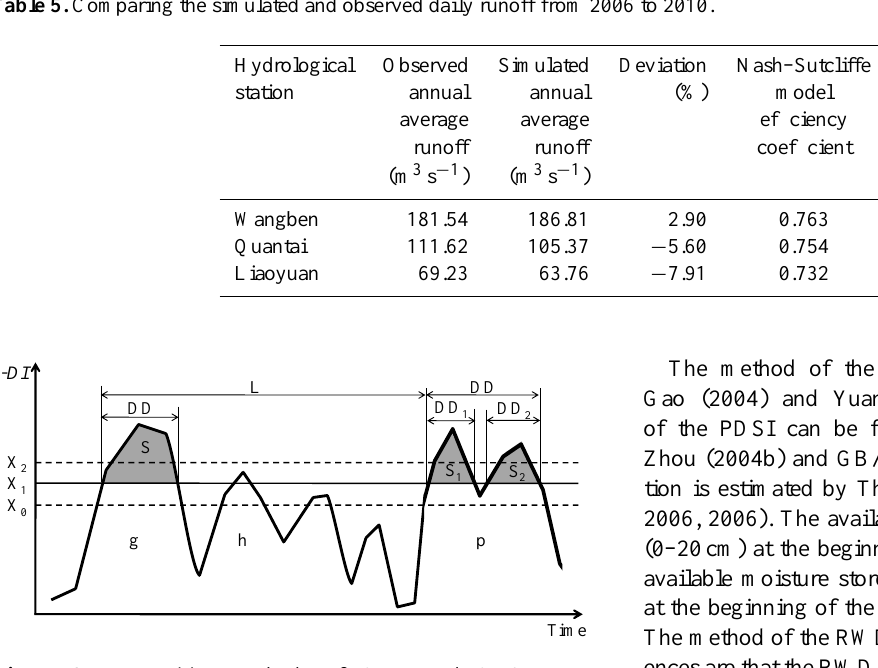
Figure 3. Recognition methods of GDD and GDS. Note: L is drought inter-arrival time between ( n + 1)th drought and n th